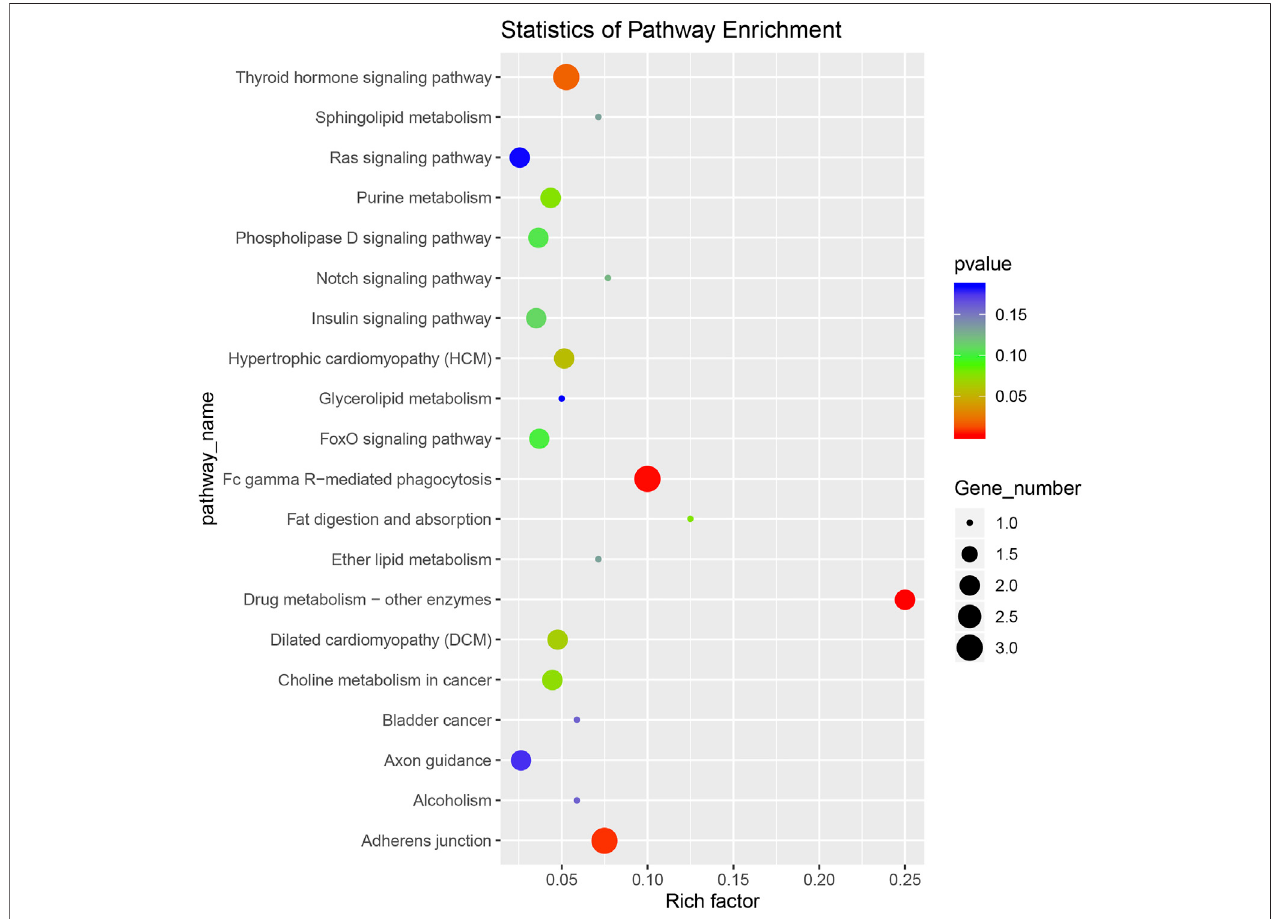
FIGURE 5 | A scatter plot of the Kyoto Encyclopedia of Genes and Genomes (KEGG) enrichment analysis of differentially expressed circRNA-hosting genes.